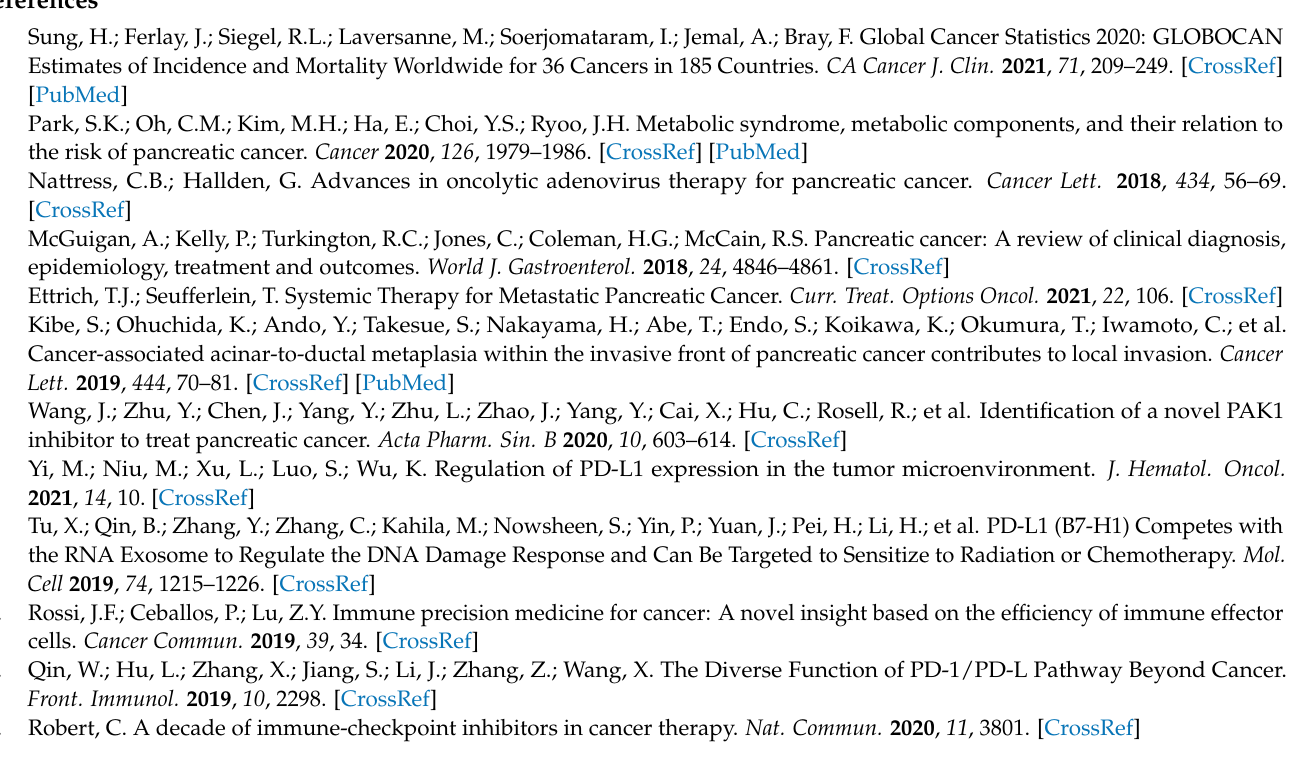
analysis, Figure S3: Counterstaining of moesin with actin in HeLa cells, Figure S4: RNA interference